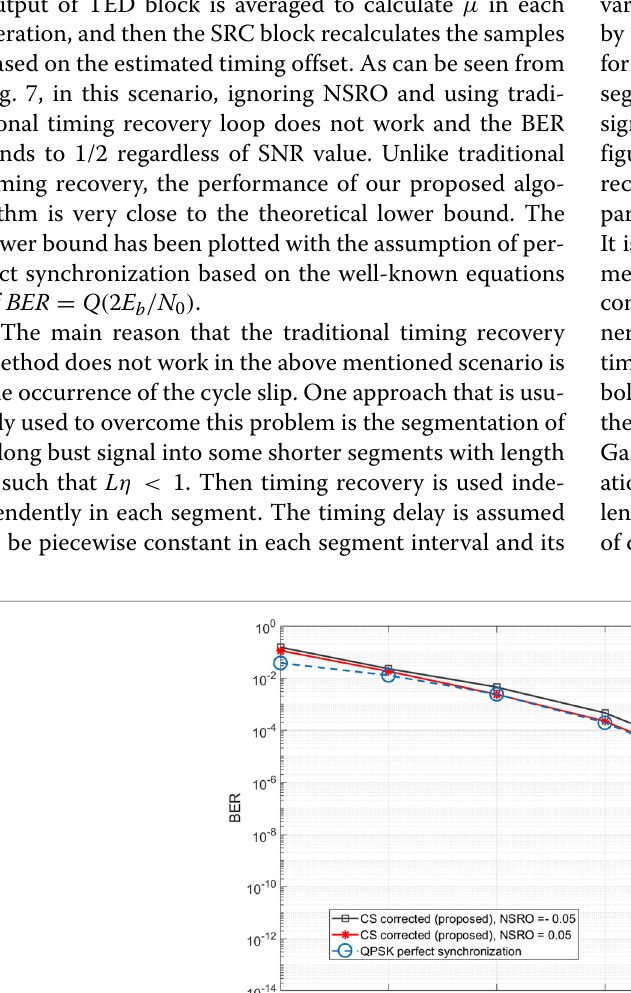
Fig. 10 BER performance for different burst lengths N (cid:2) = 4096, η = 0.1